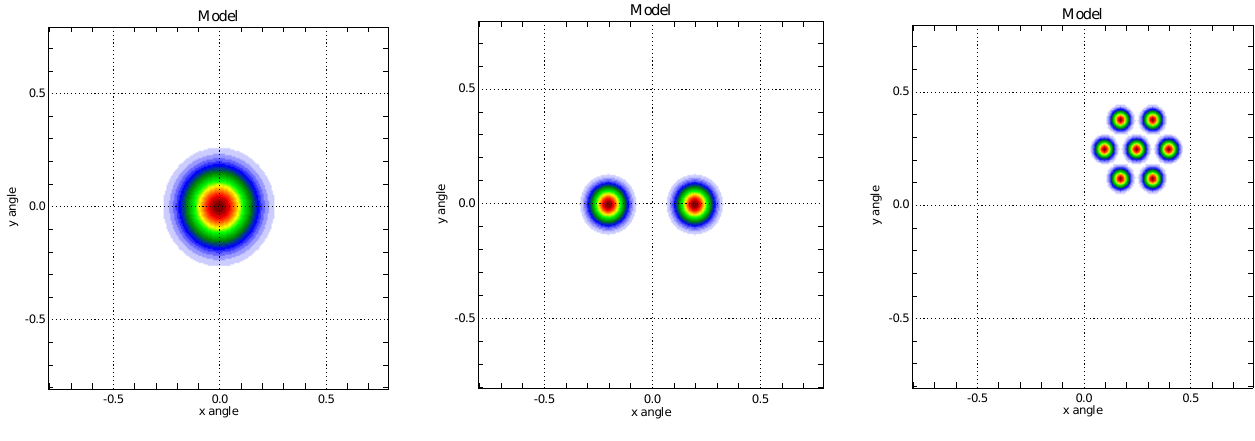
Fig. 1. The model brightnesses (true images) used as inputs to the simulations. The first model shows a single cylindrical structure. This is an (sort of baseline) image, as well as a reasonable representation of a single filament of enhanced scattering or a meteor trail echo. The second model shows two immediately neighbouring structures, which has been suggested to occur for naturally enhanced ion-acoustic echoes. The third model shows a tightly clustered group of very narrow structures. This is a crude representation of a bunch of striations which might be expected in heating experiments.